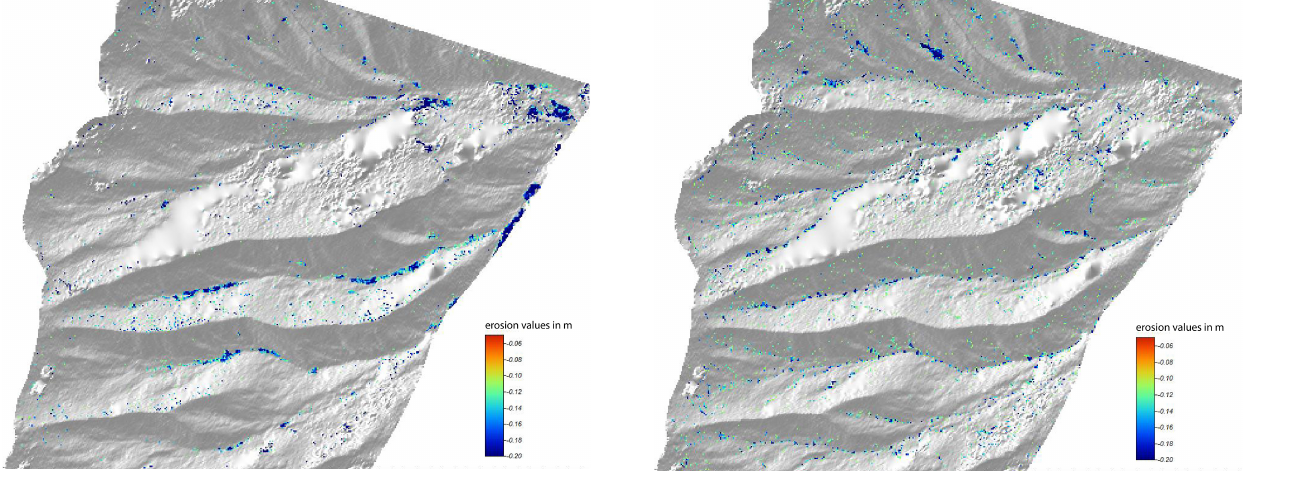
Figure 3. Surface changes from TLS data. Figure 4. Modelling results from